Question: Briefly state, in one sentence, what is plotted here.
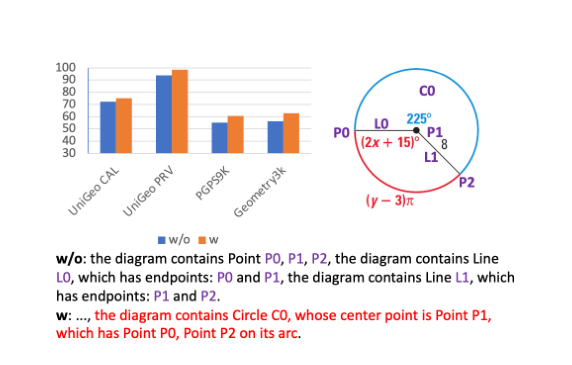
Answer: The top-left bar chart compares GOLD (T5- base as the problem-solving module) accuracy in solv- ing geometry math problems, with (w) and without (w/o) the use of geo_type_embedding. The top-right diagram is from the 375th problem in the PGPS9K dataset, while the bottom part shows the predicted diagram descrip- tions for two different cases. Purple notations in the diagram are added for better visual comprehension. The differences between the two diagram description texts are highlighted in red. It should be noted that the same texts in the w to the w/o section are omitted, which are represented by "...".